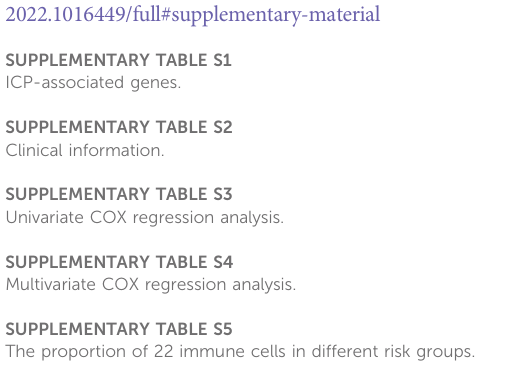
SUPPLEMENTARY TABLE S1 ICP-associated genes. SUPPLEMENTARY TABLE S2 Clinical information. SUPPLEMENTARY TABLE S3 Univariate COX regression analysis. SUPPLEMENTARY TABLE S4 Multivariate COX regression